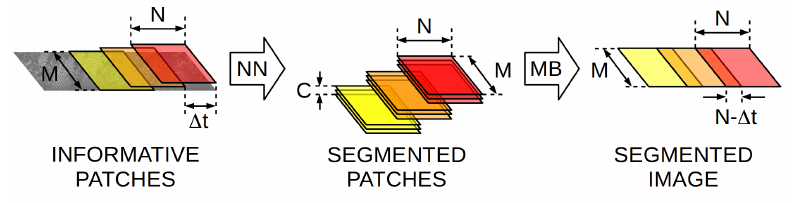
Figure 7. On-line usage of the NN and the Map Building